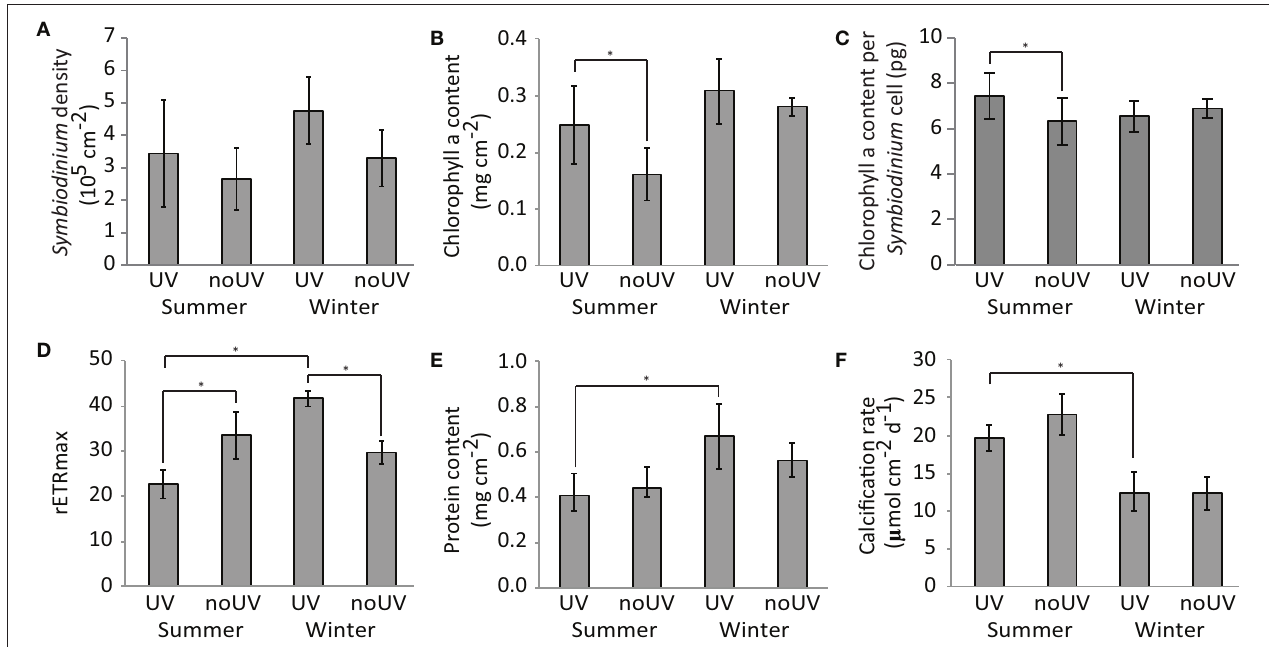
FIGURE 1 | Changes in the physiological parameters of the A. muricata holobiont [coral and Symbiodinium : (A) Sybiodinium density, (B) Chlorophyll a content, (C) Chlorophyll content per Symbiodinium cell, (D) maximum relative Electron Transport Rate, (E) Protein content, and (F) Calcification rate] under ambient or no UV radiation at two contrasting seasons (summer and winter). Data are the mean and standard deviations of five biological replicates. Comparisons indicated with *are significantly different (Tukey’s Honest Significant Difference-corrected p < 0.05).